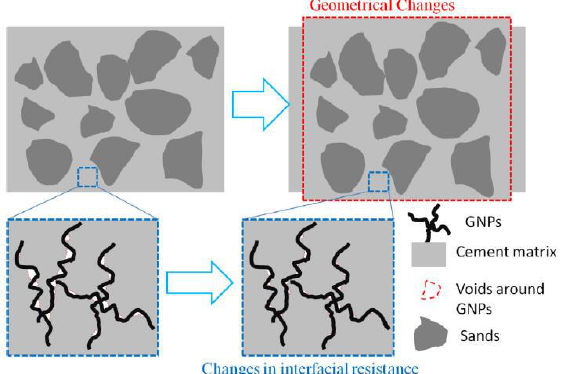
Figure 28. Schematic diagram of mechanisms for piezoresistive responses of GNP-modified cement composites. Reprinted with permission from Ref. [106]. Copyright 2019 Elsevier. composites. Reprinted with permission from Ref. [106]. Copyright 2019